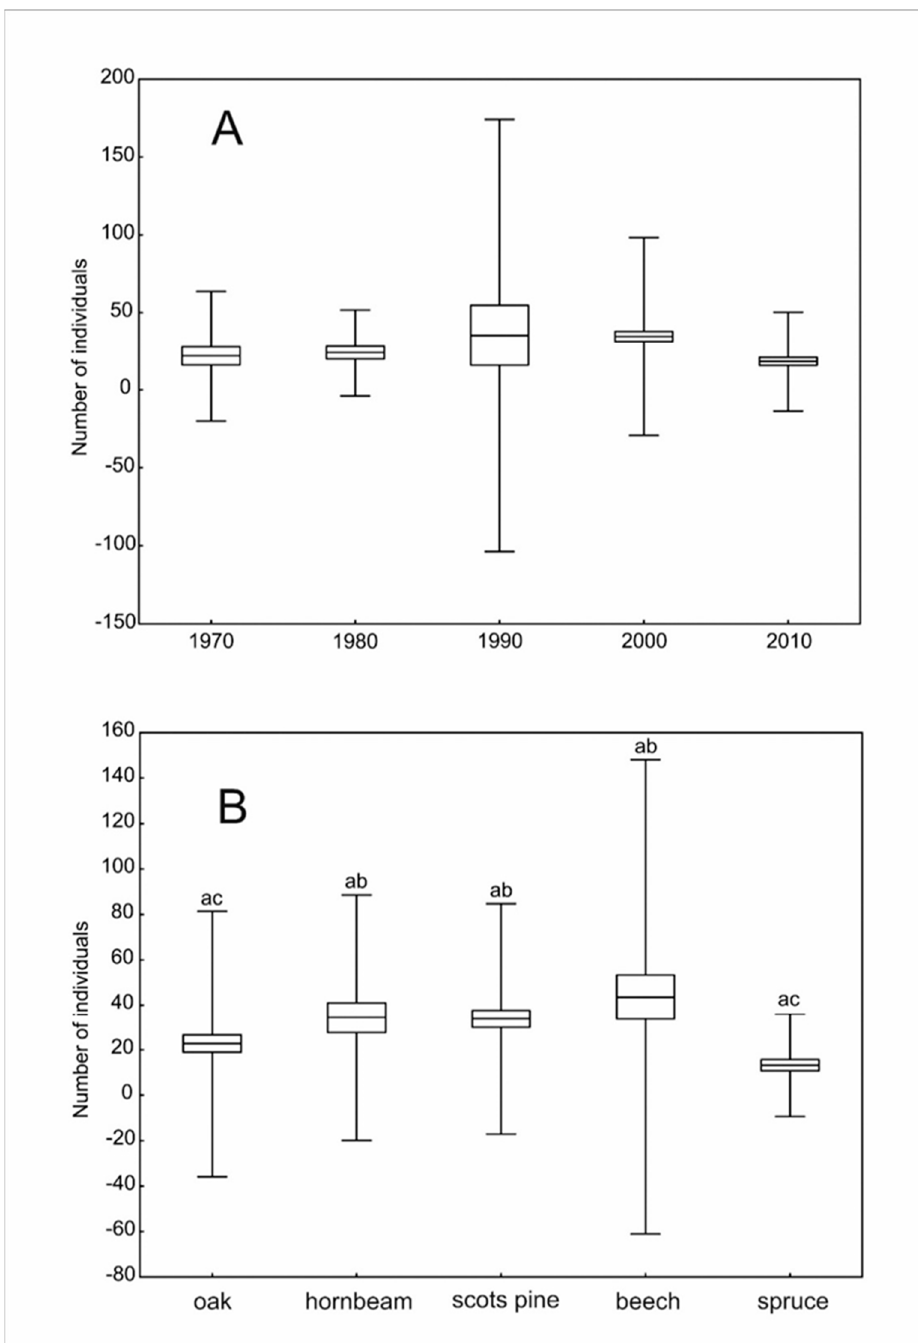
Figure 6. Average number of Uropodina specimens: ( A ) in relation to research period, and ( B ) in relation to tree species, box—standard error, whiskers—standard deviation. Letters a, b—statistically significant differences between species at the level of p < 0.05.